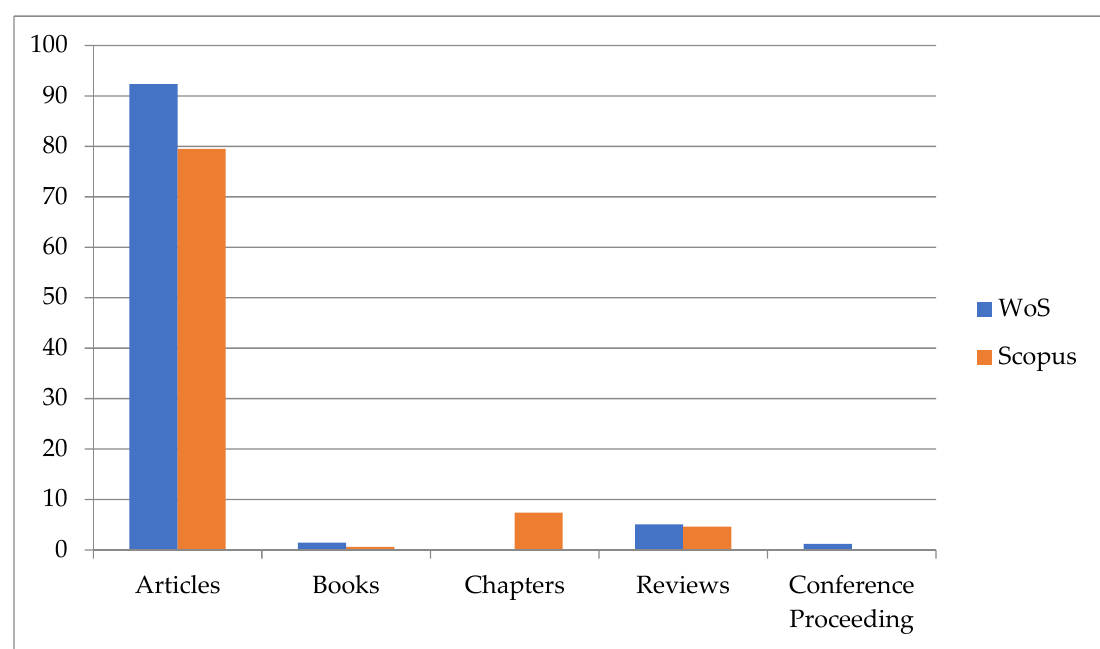
Figure 7. Type of document.